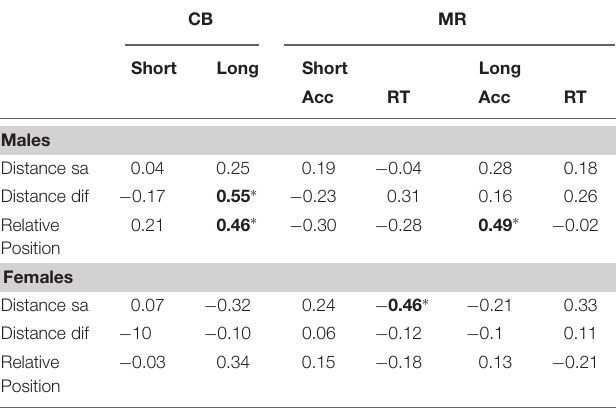
TABLE 3 | Correlation between configurational tasks and psychometric